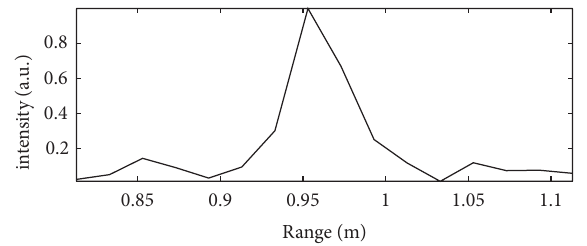
Figure 13: CS reconstruction of the scene using a coarse wall dictionary for wall ranging. The actual wall was located at 0.95 m.